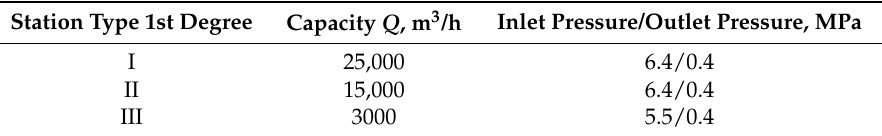
Table 1. Capacity of the first-stage reduction and measuring stations.